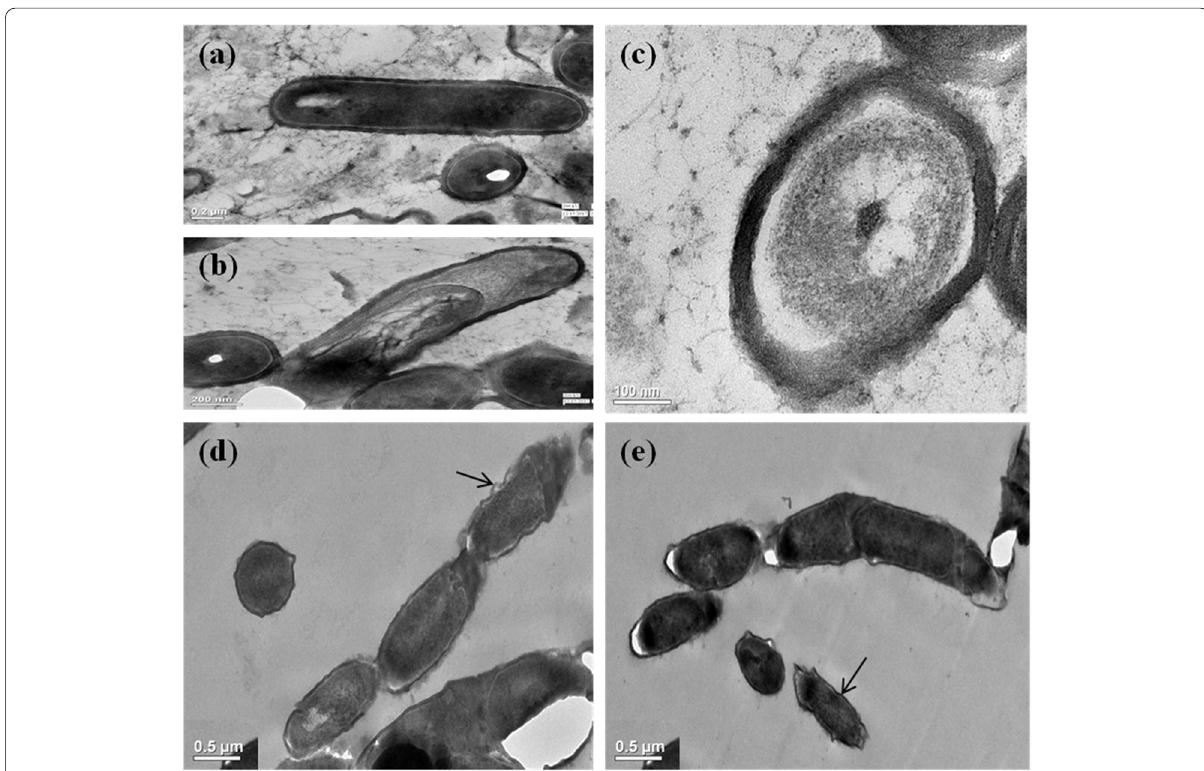
Fig. 6 Transmission electron microscopy imaging of MHN12 cells under salt stress. a – c Longitudinal and cross section of unstressed bacterial cell (0.5%NaCl) exhibiting normal rod shape and regular cell wall. d , e Longitudinal section of stressed bacterium (15% NaCl) exhibiting incomplete cell division and irregular cell wall (indicated by arrow). Scale bar: a , b 0.2 μm c 0.1 μm. d , e 0.5